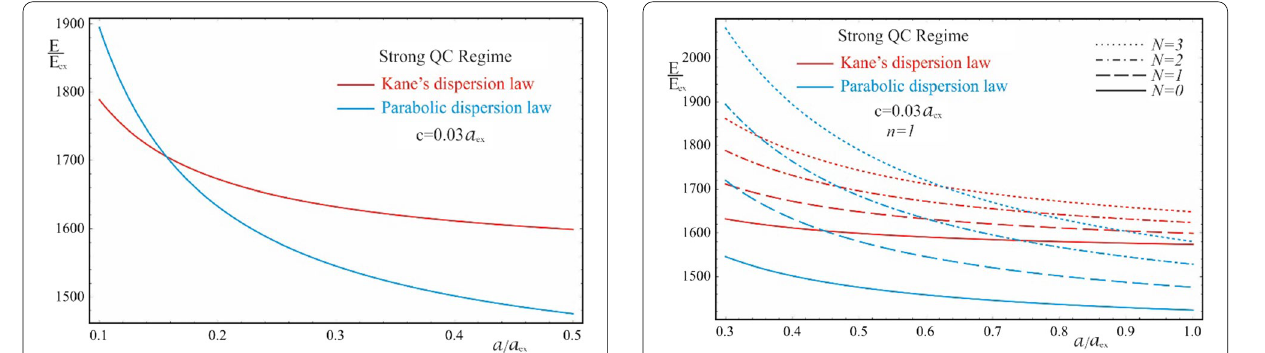
Fig. 6 The dependence of the first family of the energy levels on the major semiaxis a at the fixed value of the minor semiaxis c for the Kane’s and parabolic dispersion laws of